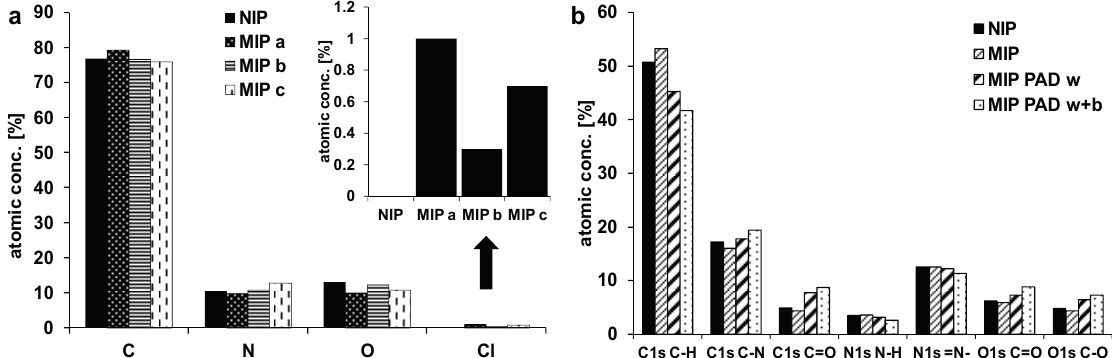
Figure 7. ( a ) XPS atomic concentration for NIP and MIP a (unwashed), MIP b (washed with ethanol), and MIP c (washed with acetonitrile); ( b ) XPS atomic concentration of C1s, N1s, and O1s components for NIP and MIP after polymerization, and for MIP after PAD washing and subsequent clofibric acid